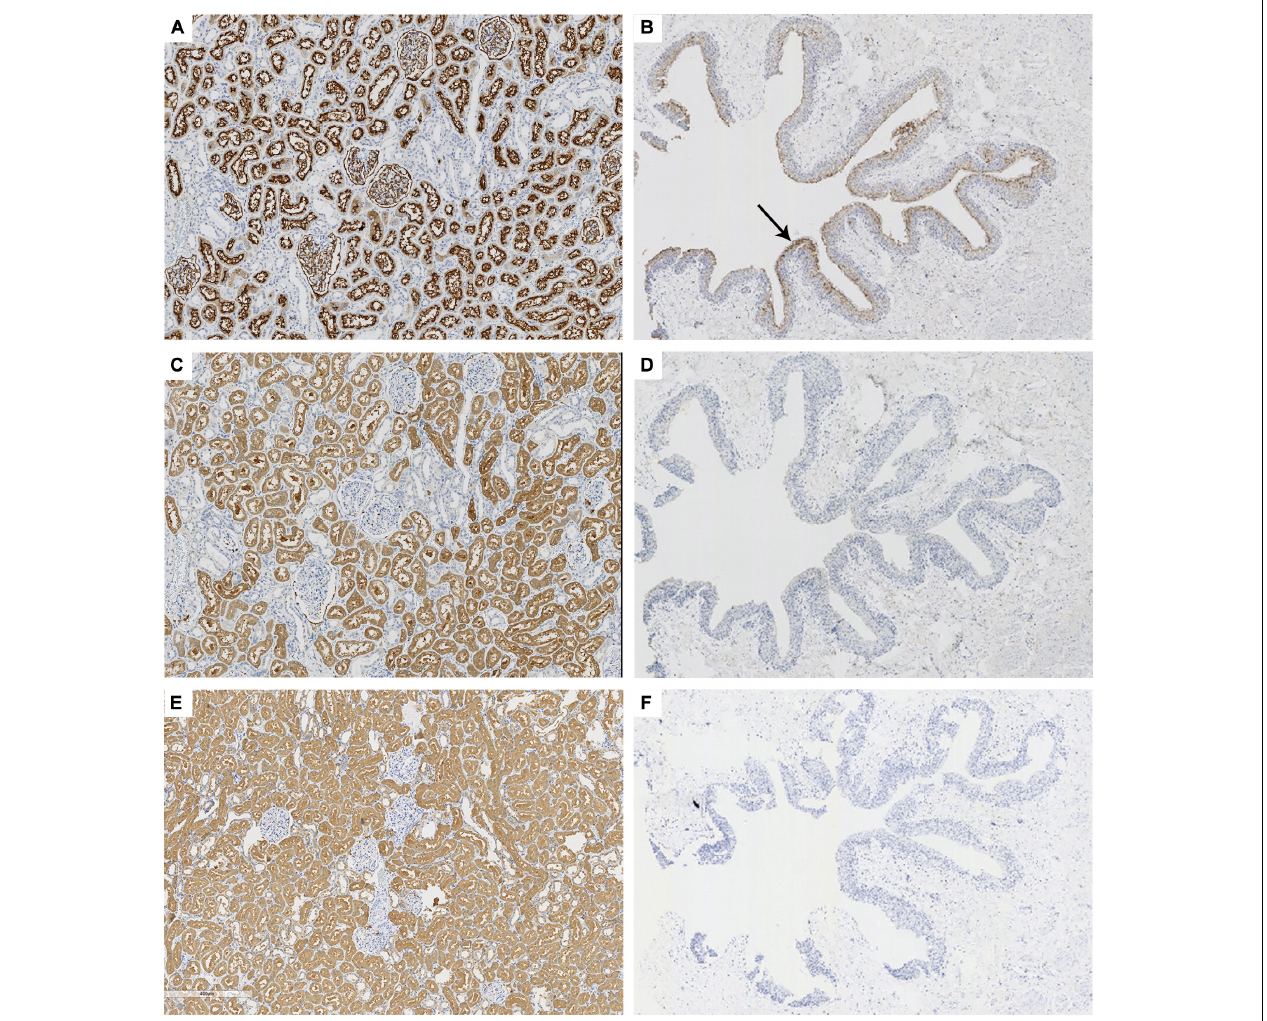
FIGURE 2 | Immunohistochemical staining of CD10, 58K, and HGD in kidney and ureter tissues. Anti-CD10, anti-58K, and anti-HGD immunostaining in renal tissue ( A,C,E , × 60) and transitional epithelium ( B,D,F , × 18). Black arrow in (B) referred that CD10 was positive in the transitional epithelium (brown). 58-kDa Golgi protein (58K); homogentisate 1, 2-dioxygenase (HGD).